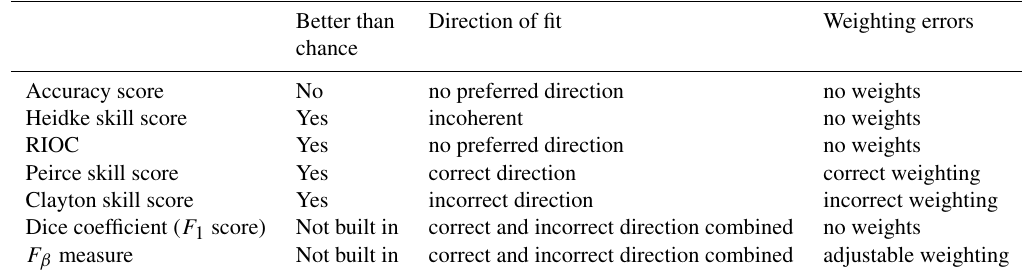
Table 7. Summary comparison of skill measures in relation to the three adequacy constraints for RSE forecasting. Better than Direction of fit Weighting